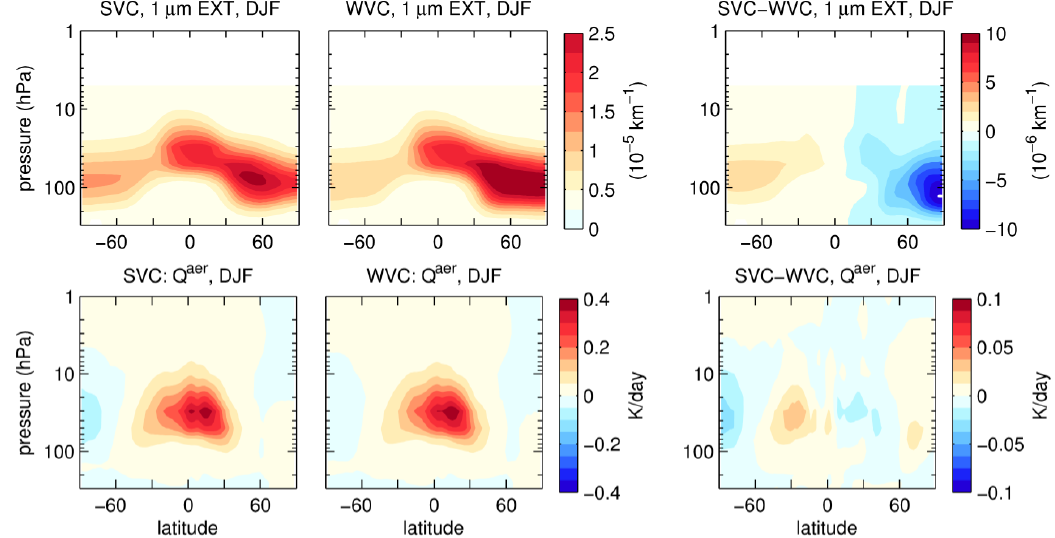
Figure 5. (top) Latitude–pressure distributions of 1µm aerosol extinction in the SVC and WVC volcanic aerosol forcing sets in first DJF Figure 5: (top) latitude-pressure distributions of 1 μm aerosol extinction in the SVC and WVC volcanic 768 after Pinatubo (winter 1991/92). (bottom) Aerosol radiative heating ( Q aer ) as computed within the MPI-ESM model for each forcing set. aerosol forcing sets in first DJF after Pinatubo (winter 1991/92). (bottom) aerosol radiative heating (Q aer ) 769 Right-hand column shows SVC–WVC differences for both 1µm extinction and Q aer as computed within the MPI-ESM model for each forcing set. Right-hand column shows SVC-WVC 770 differences for both 1 μm extinction and Q aer . 771